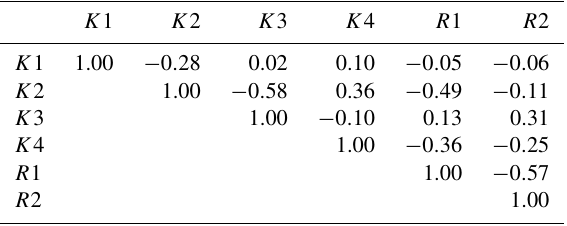
Table 2. Correlation coefficients among different